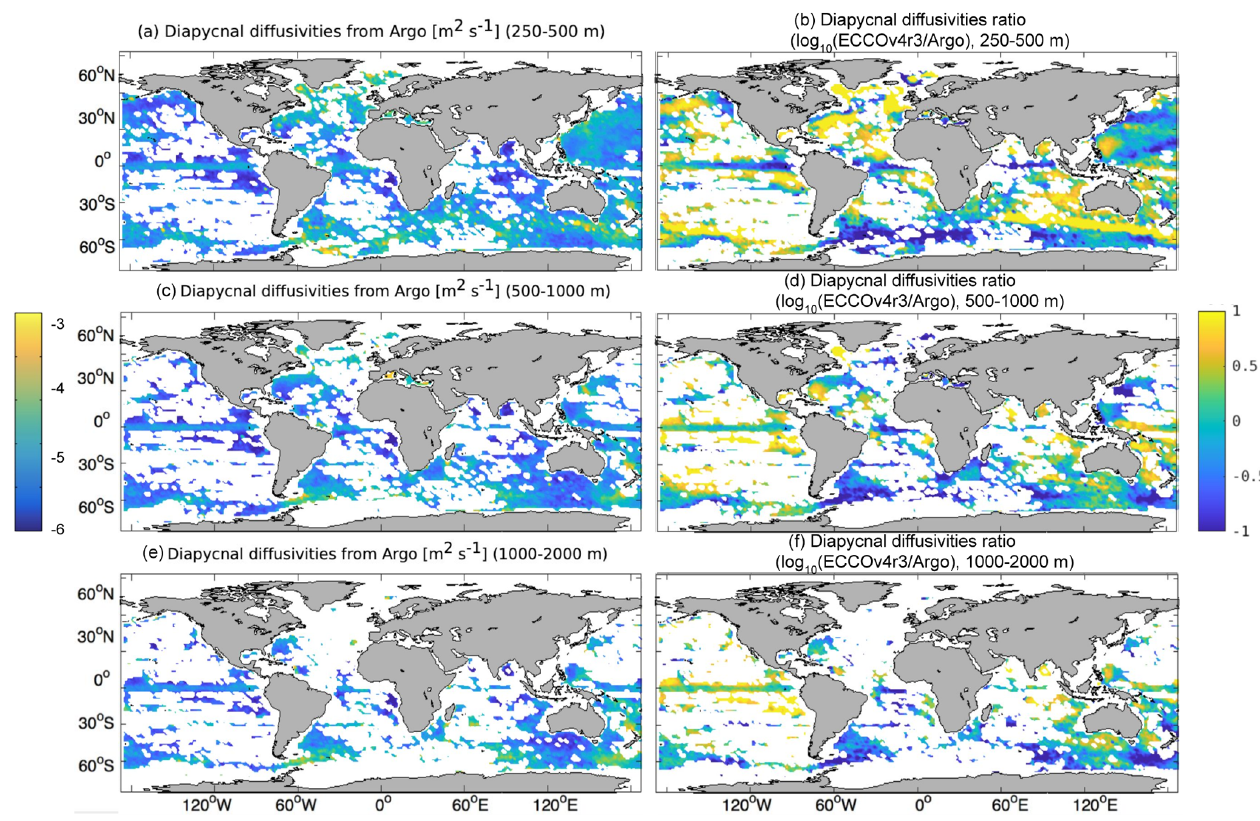
Figure 6. Shown are (a , c , and e) the base-10 logarithms of κ ρ, Argo (units in m 2 s − 1 ) and (b , d , and f) the base-10 logarithms of the ratios of the time-averaged κ ρ, ECCO to κ ρ, Argo . Panels (a) and (b) show an average over 250–500m depth. Panels (c) and (d) show an average over 500–1000m depth. Panels (e) and (f) show an average over 1000–2000m depth. White areas in the ocean indicate insufficient Argo data to derive κ ρ, Argo